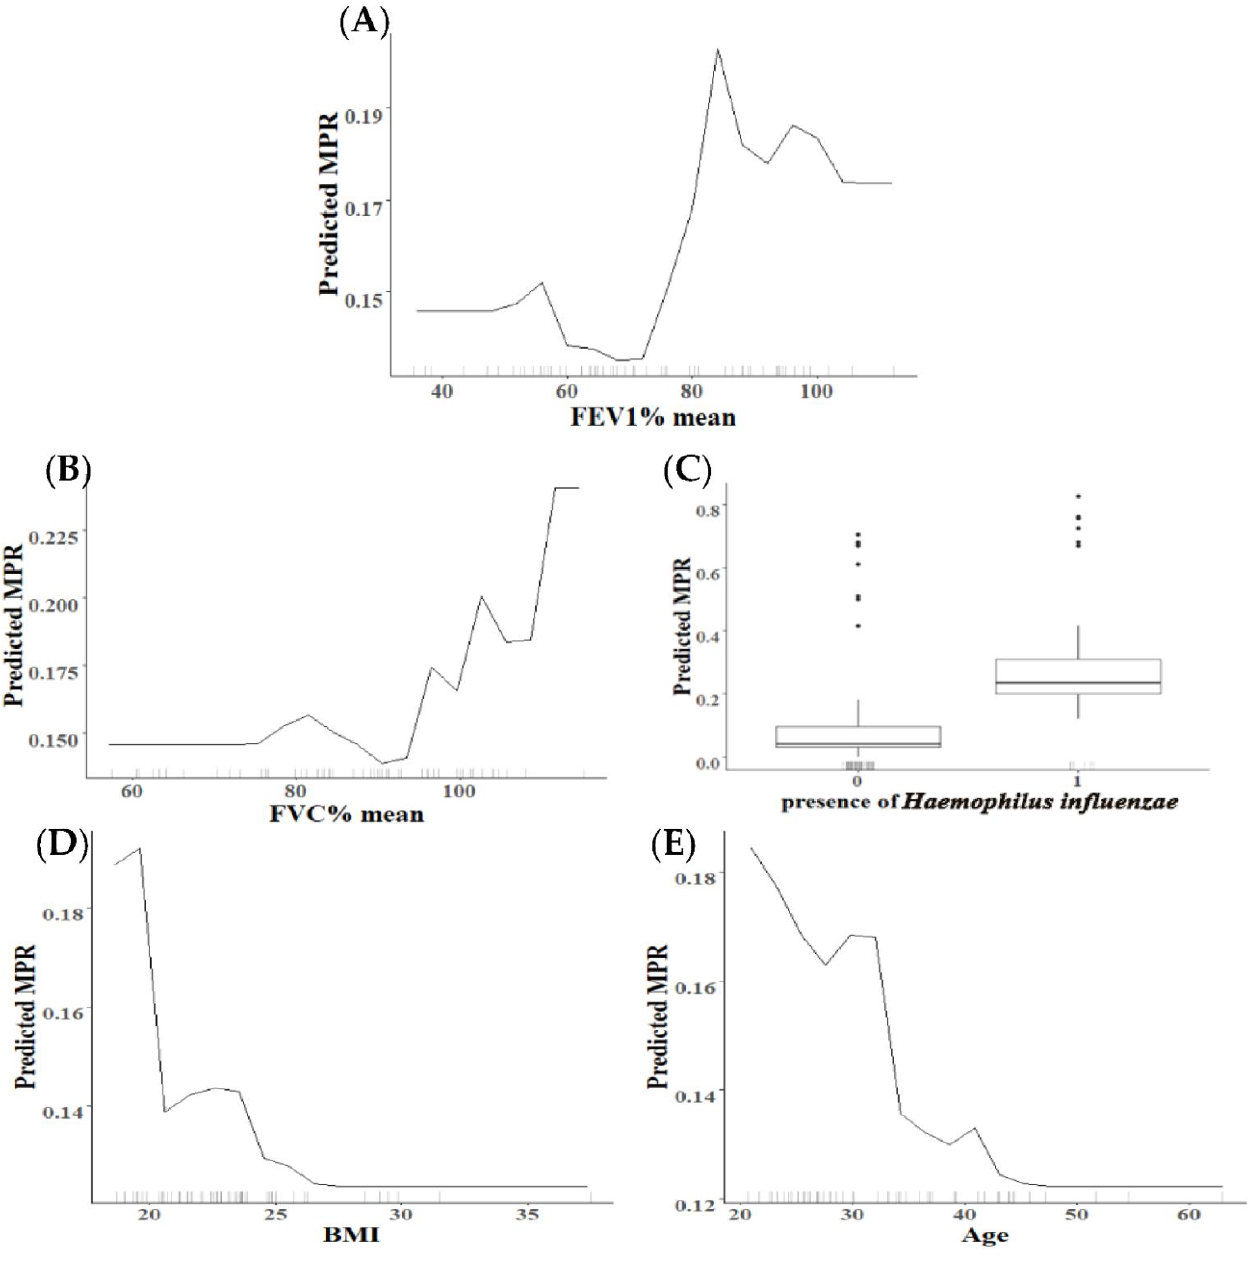
Figure 8. Partial dependence plots for the top 5 most important factors (panel A: FEV 1 % mean, panel B: FVC% mean, panel C: presence of Haemophilus influenzae , panel D: BMI, panel E: Age) for low compliance.